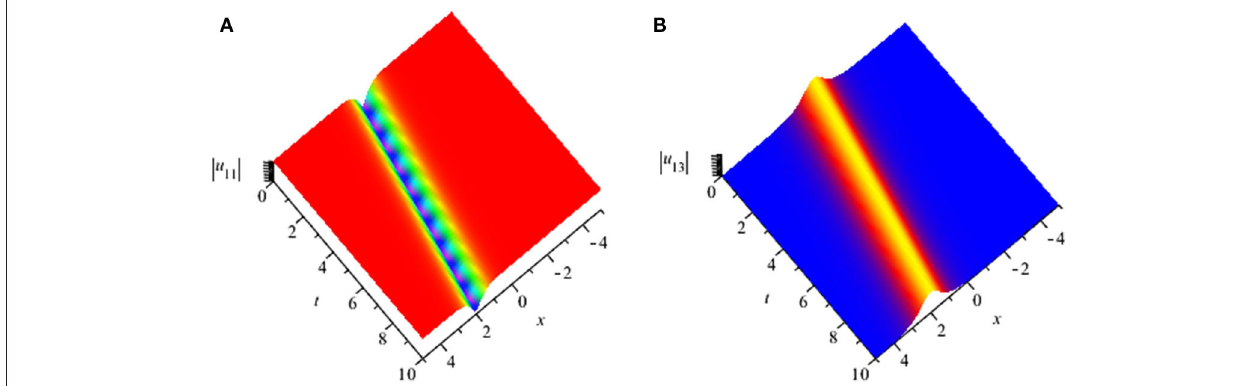
FIGURE 2 | (A) The 3-dimensional graph of | u 11 ( x , t ) | for α 1 = 1, α 2 = 1, α 3 = 1, α 4 = 1, κ = − 0.1, and θ = 0; (B) The 3-dimensional graph of | u 13 ( x , t ) | for α 1 = 1, α 2 = 1, α 3 = 1, α 4 = 1, κ = − 0.1, and θ =